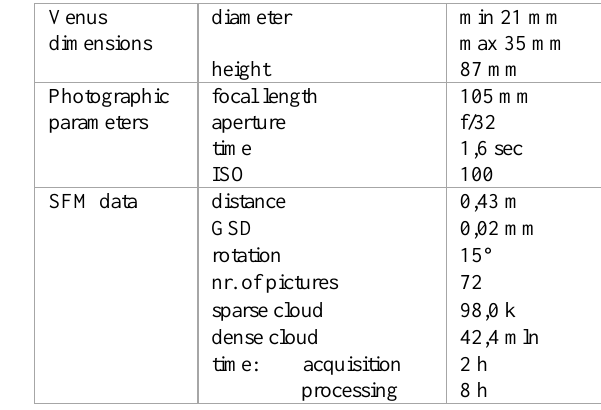
Figure 9. The overlapping between different scans after the